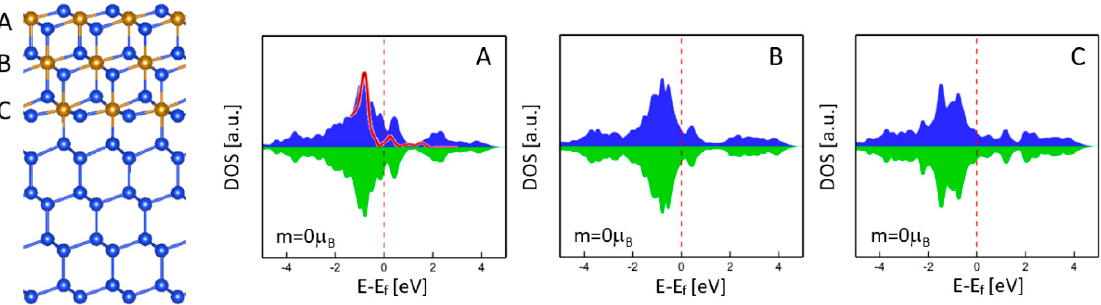
Figure 4. Atomic structure and DOS of Fe atoms in γ -FeSi 2 /Si(111) epitaxial nanoslabs with three Fe layers ( A – C ). The red curve is an experimental DOS reproduced from [17].